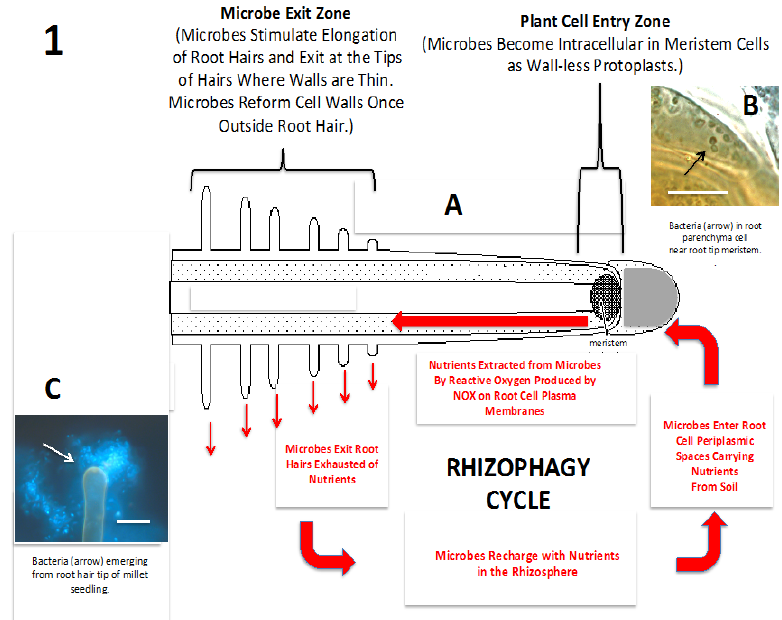
Figure 1. Diagrammatic representation of the rhizophagy cycle. ( A ) Diagram of the rhizophagy cycle showing microbes entering root cells at the root tip meristem and exiting root cells at the tips of elongating root hairs. Rhizophagy cycle microbes alternate between an intracellular endophytic phase and a free-living soils phase; soil nutrients are acquired in the free-living soil phase and extracted oxidatively in the intracellular endophytic phase; ( B ) Shows bacteria (arrow) in the periplasmic space of parenchyma cell near root tip meristem of an Agave sp. seedling (bar = 20 µm; stained with 3,3-diaminobenzidine followed by aniline blue); ( C ) Bacteria (arrow) emerging from root hair tip of grass seedling (bar = 20 µm; stained with fluorescent nucleic stain SYTO 9).